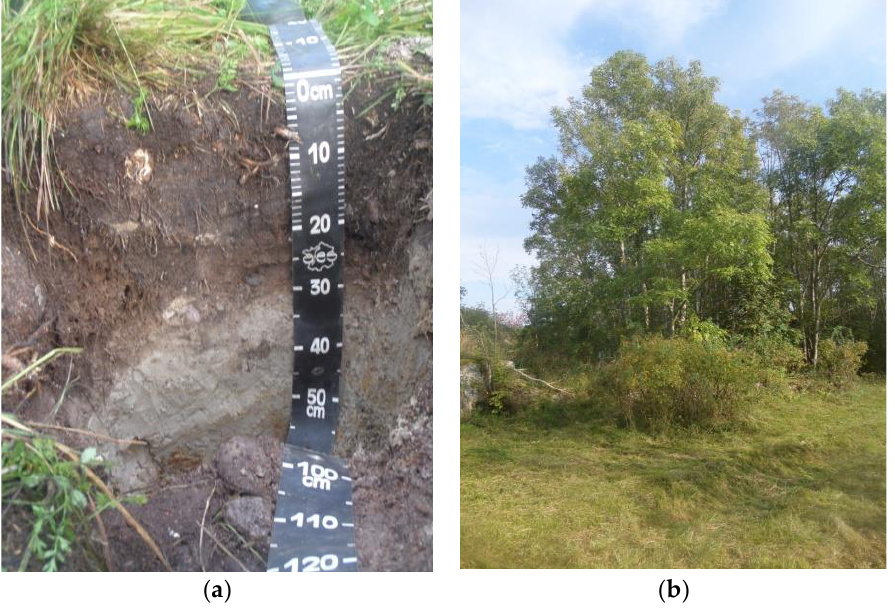
Figure 6. Agro-soddy-podbur gley post-agrogenic formed on boulders moraine (Entic Stagnic Gleyic Podzol — WRB): ( a ) soil profile; ( b ) vegetation and landscape of boulders moraine.